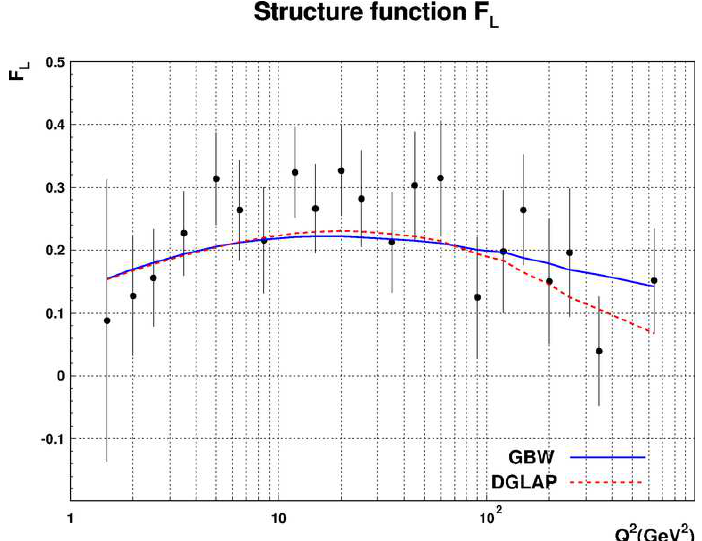
JHEP03(2018)102 b 2 (left panel) and bottom F 2